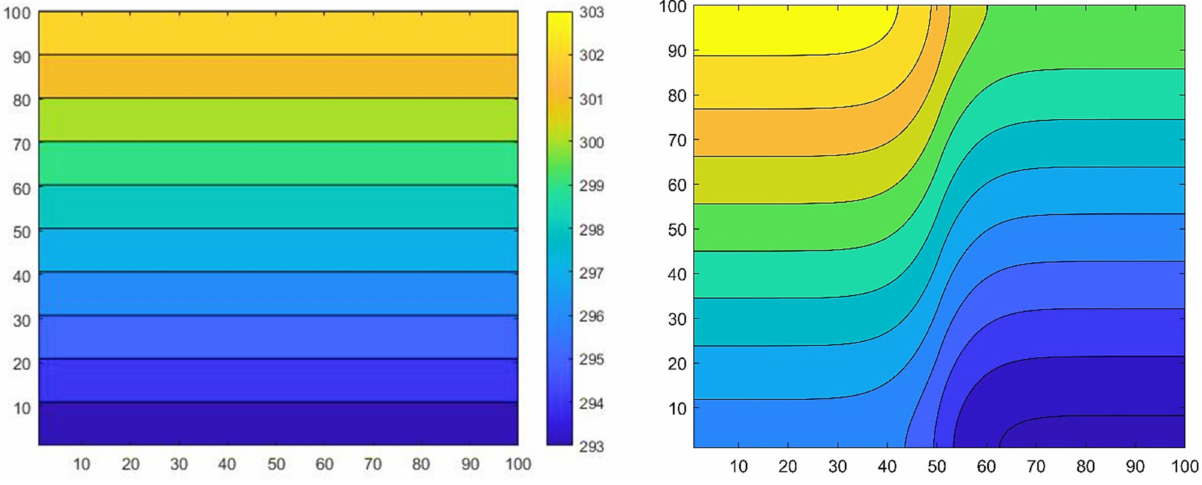
Figure 8. The temperature distribution contour in Kelvin for the equidistant mesh at initial ( left ) and final time ( right ), in the case of multilayer cross-sectional area. The numbers on the vertical and horizontal axes of the contours are the indices of the cells, which are the same as the coordinates in cm units.